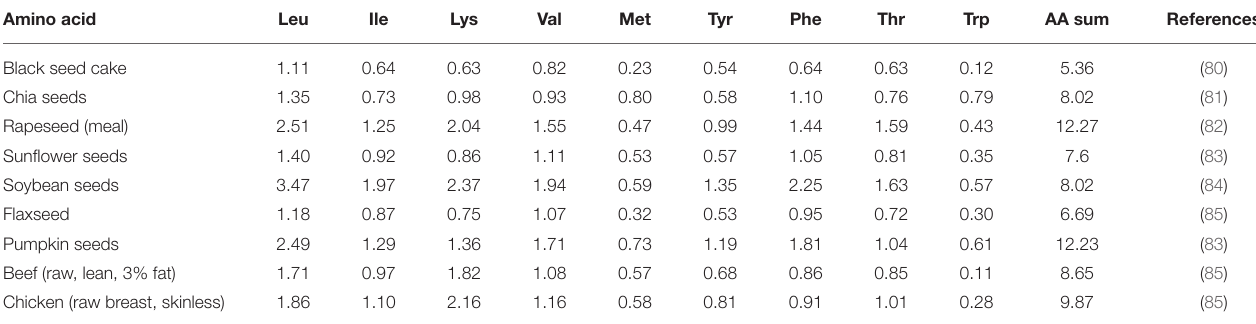
TABLE 3 | Essential amino acid composition of the black seed cake, oilseeds, and raw meat (g/100g). Amino acid Leu Ile Lys